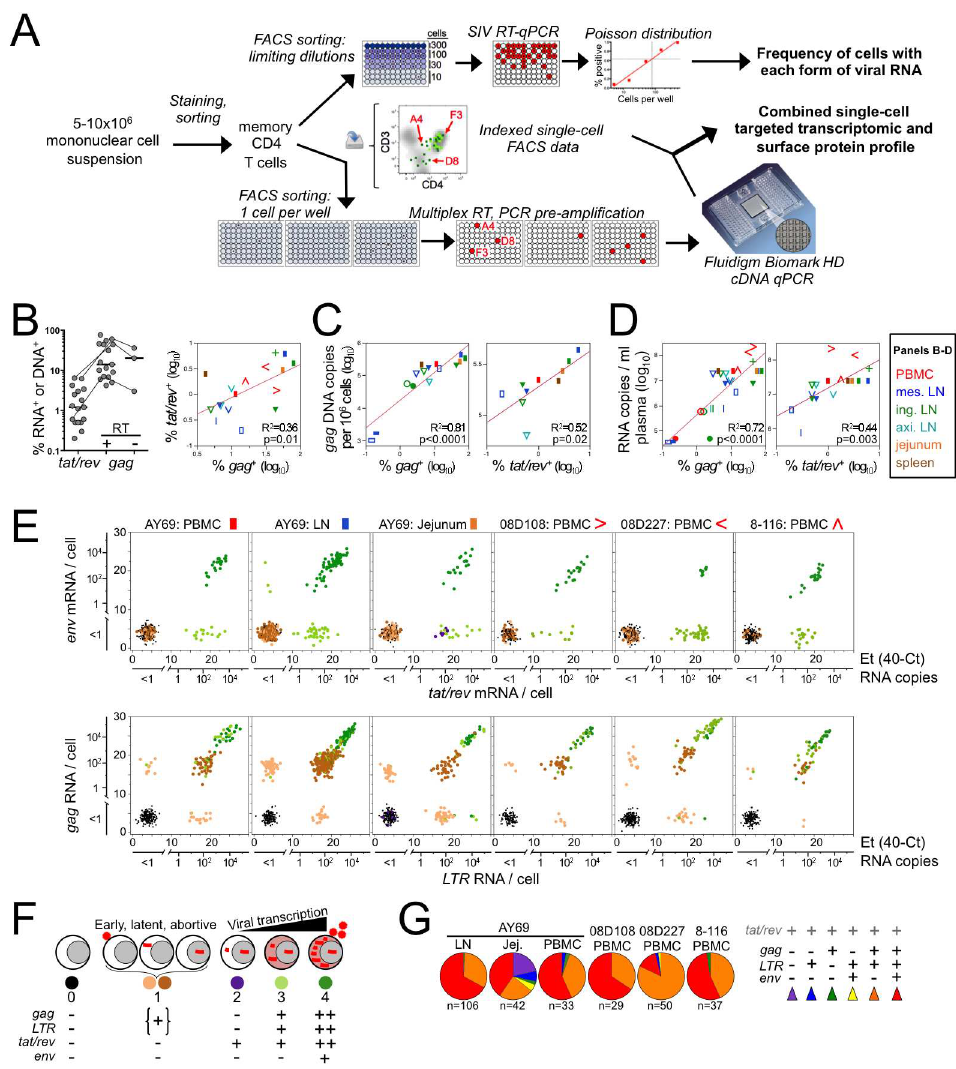
Fig 1. in vivo SIV-infected cell frequency and single-cell viral RNA expression. SIV-infected macaque specimens from 14 animals were surveyedfor splicedand unsplicednucleicacid positive memory (CD95+) CD4 T-cells by limiting dilutionFACS sorting and qPCR. Animals are describedin S1 Table. (A) Schematicof the experimental workflow. (B) The frequencyof tat/rev+ and gag+ cells are plotted alongside(left) and against each other (right), against total proviral DNA ( gag ) in bulk sorted memory CD4 T-cells (C) , and against concurrent viremia (D) . gag DNA + cell frequency, determined by excludingreverse transcriptase (“RT–“), is also shown for a subset in (B); bars represent means. In bivariateplots, each animal is represented by a unique symbol and chronic infectionby circles. (E) Single-cellSIV transcript levels within memory CD4 T cells from d10 SIVmac251 (AY69, n = 3 tissues) and d14 SIVsmE660 (PBMC, n = 3 animals) infected rhesus macaques (subset from B-D). The relative (Et) and absolutequantity of env and tat/rev (top) and gag and LTR (bottom) transcripts per cell is shown. Undetectable mRNA is plotted as a scatter near the origin for visualization. Symbol color corresponds to the number and type of viral transcripts detected in each cell; number of cells analyzedis provided in S3 Table. (F) Pictorial of viral life cycle with corresponding combination of viral genes present and symbol colors used herein. See also S1 Fig. (G) Pie charts depict the proportionof tat/rev + cells expressingadditional viral genes. Experiments were performed once for each animaland all data is